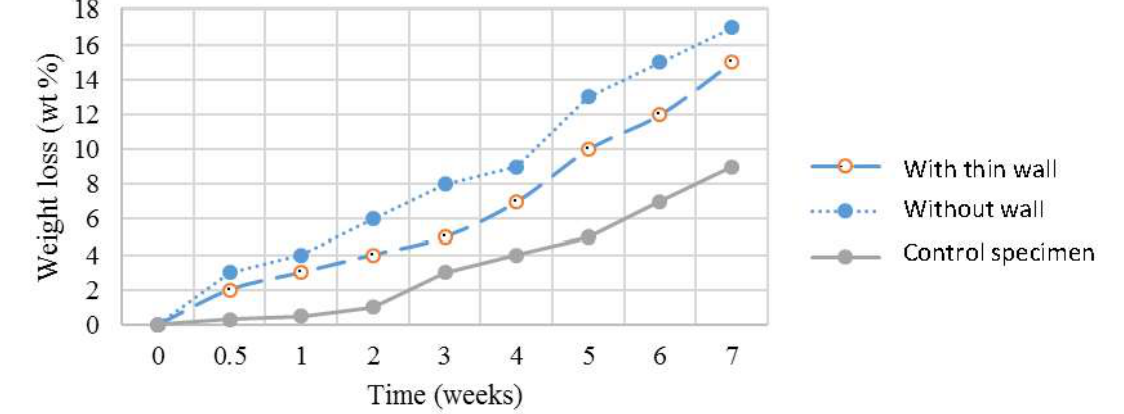
Figure 9. Degradation profile of the 3D scaffolds.